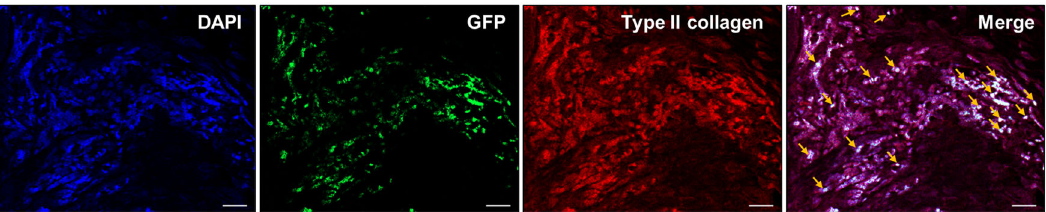
Fig. 7 Immuno fl uorescence staining of GFP and type II collagen in BMSCs. GFP/type II collagen positive BMSCs were detected using immuno fl uorescence staining in the transplanted cartilage defect site at 4 weeks (yellow arrows). Scale bar: 20 μ